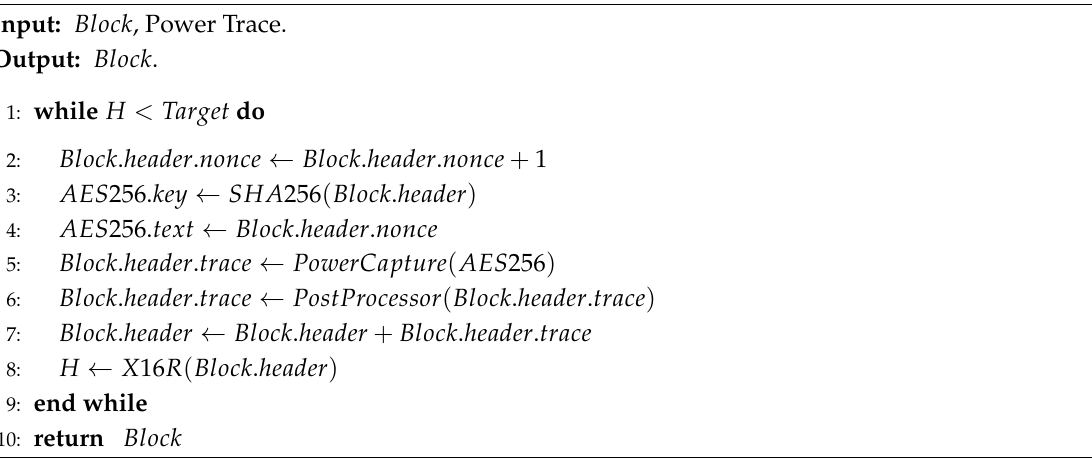
Algorithm 1 Proposed PoW